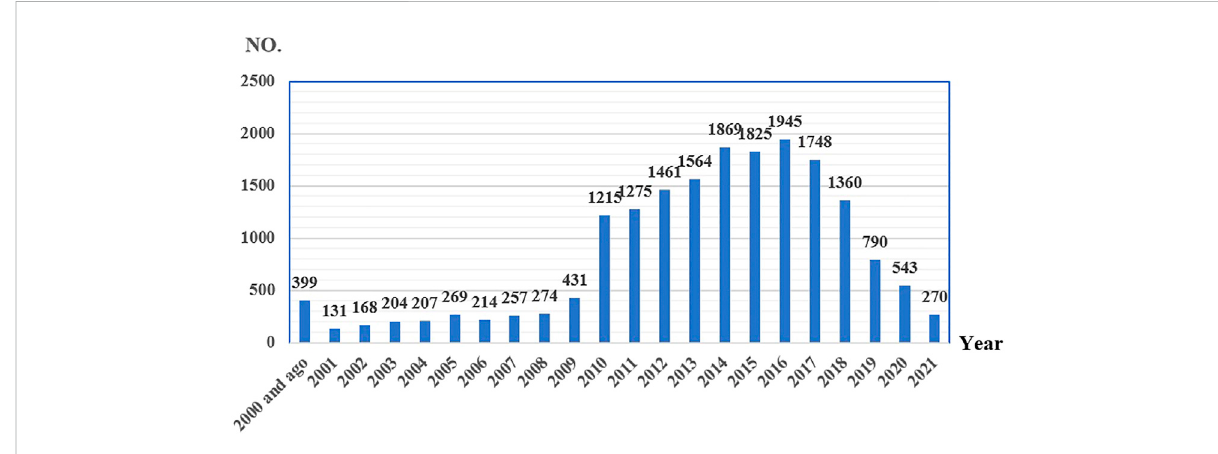
FIGURE 2 Reporting years of antiresorptive-related to osteonecrosis of the jaw collected from FAERS (number of